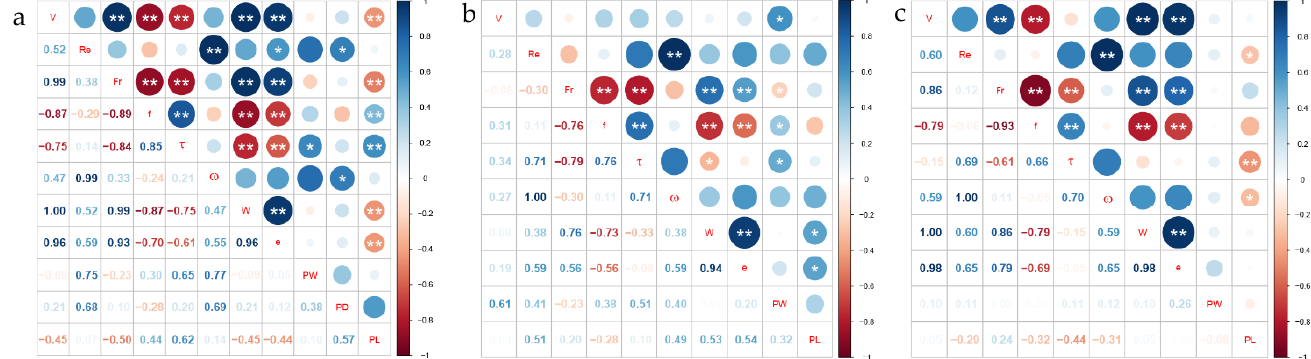
Figure 6. ( a – c ) represent the correlation matrices of hydraulics in the gully development process of headcut-incision, headcut-expansion and stabilization on the platform, respectively. V is flow velocity, ** represents p < 0.01, * represents p < 0.05.